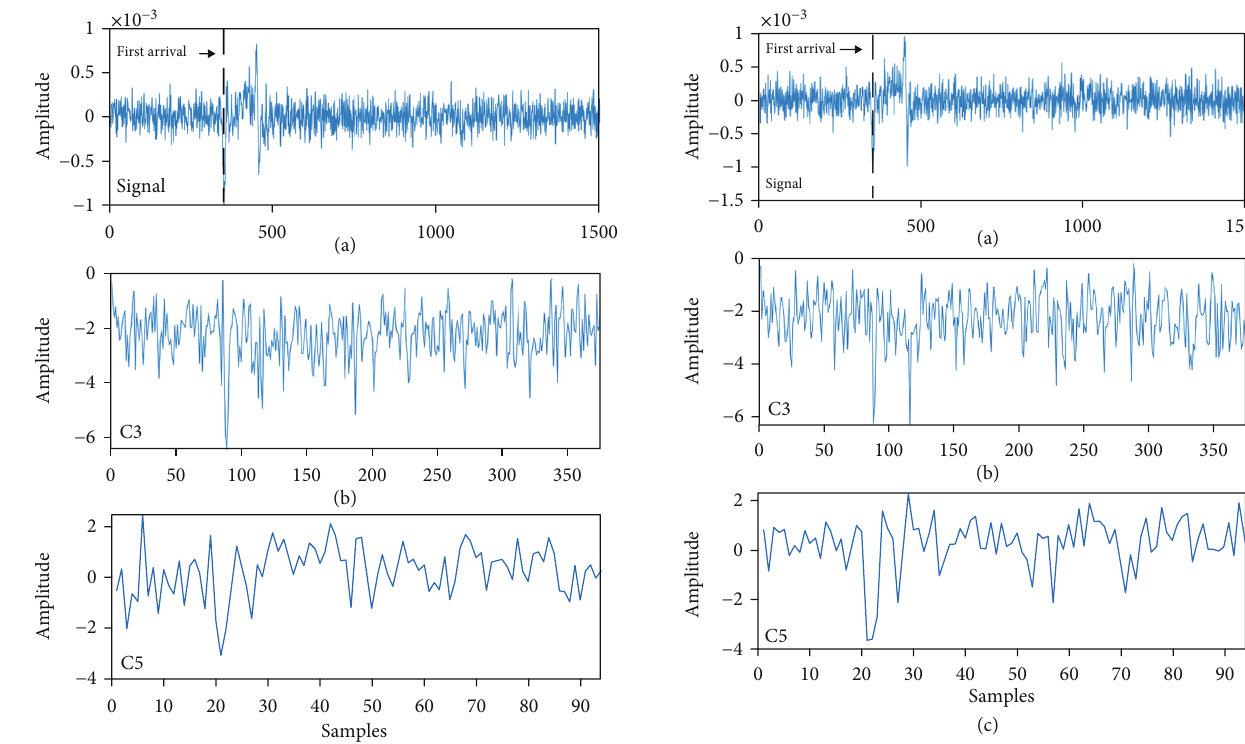
Figure 14: Forward modeling signal with -5-dB Gaussian noise added and its intermediate features extracted by the UNet++. (a) The forward modeling signal with -5-dB Gaussian noise added. (b) Intermediate features of the signal extracted by C3 layer. (c) Intermediate features of the signal extracted by C5